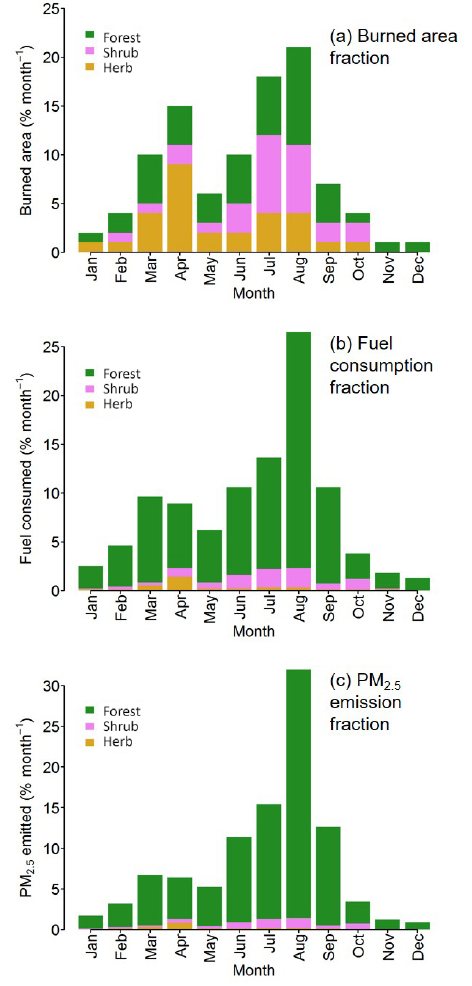
Figure 12. Monthly distributions of burned area, fuel consumption, and PM 2 . 5 emitted over 2003–2015, broken down by cover